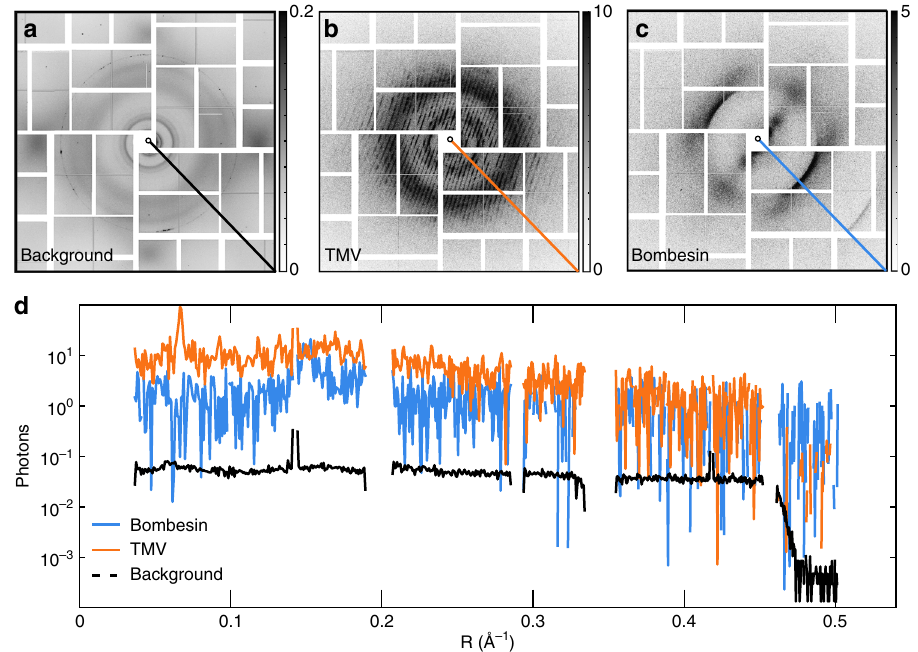
Fig. 3 Diffraction images obtained at the LCLS in the CXI nanofocus chamber. a The average background from 1,607 selected frames with graphene but without sample. The diffuse scattering of the silicon and some contamination is visible. Single frames from b TMV and c the amyloid bombesin. a – c The grayscale shows photons per pixel. The average background contains 119,556 scattered photons, which is equivalent to about 0.050 photons/pixel ( a ). d Traces from the diagonal lines in ( a – c ) plotted as a function of reciprocal resolution R (Å − 1 ). The average background of graphene-covered holes is two orders of magnitude lower than that due to the samples